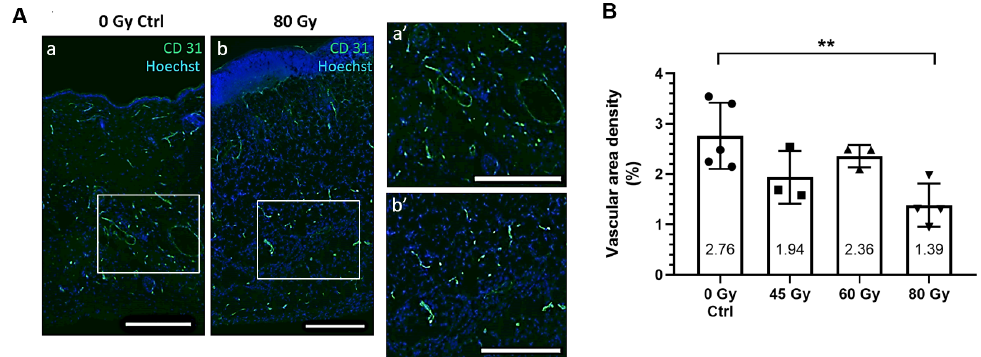
Figure 6. Vascularity is altered in irradiated skin. ( A ) Immunolabeling for CD31 on a representative skin section of ( a ) non-irradiated control skin, and ( b ) 80 Gy irradiated skin 28 days after irradiation. Nuclei are stained with Hoechst. ( a’ , b’ ) are magnifications of the areas delimited by the white boxes in ( a , b ). Bars = 200 µ m. ( B ) Vascular area density determined from the quantification of CD31-positive structures present in the dermis. Statistics: mean ± SD. n = 3–5 mice/group, One-way ANOVA with Dunnett’s multiple comparisons test ** p < 0.01.